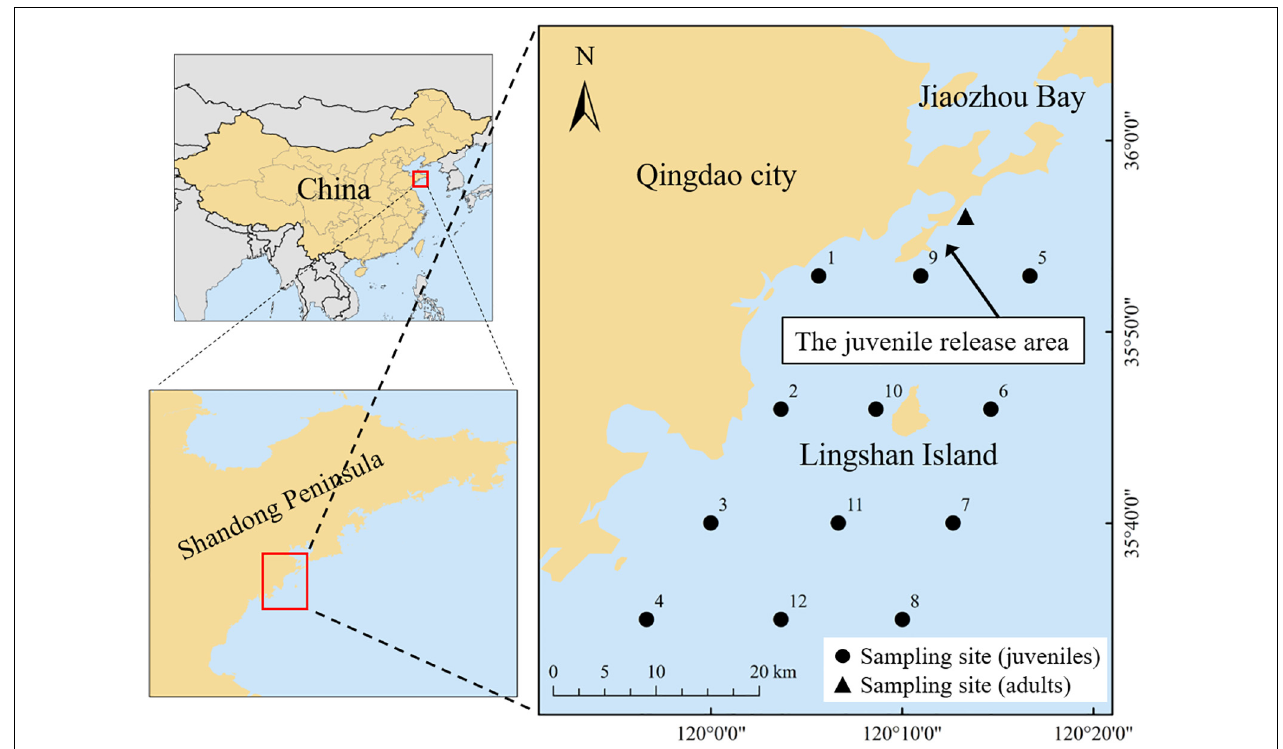
FIGURE 1 | Sampling stations for Sepia